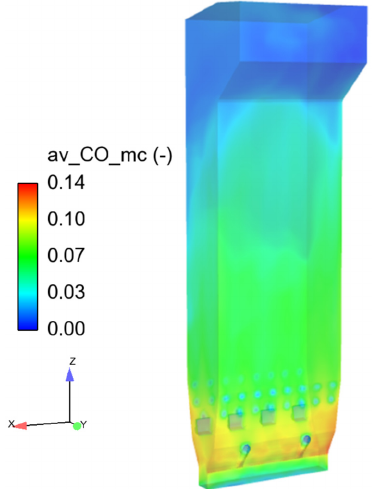
Figure 13. Three-dimensional contour of CO concentration in Case 2. Table 5. Comparisons of CO reduction measures and performance with previous works.